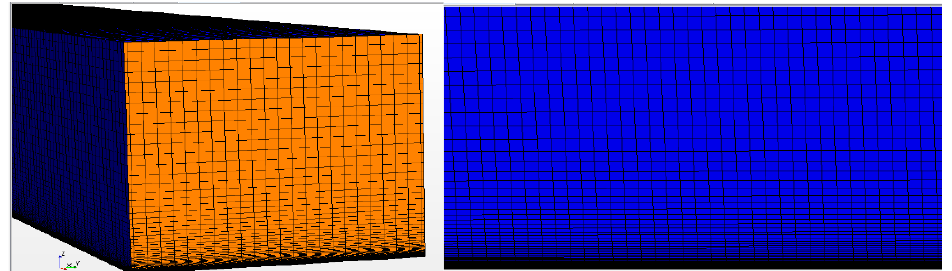
Figure 4. The computational domain meshed using the trimmed mostly hexahedral cells with a prism-layer option. The total prism layer thickness is set to 14 m from the wall, whilst the base cell size is 0.1m. The maximum surface cell size is set to 2 m, with the overall number of cells being ~8,000,000 cells.